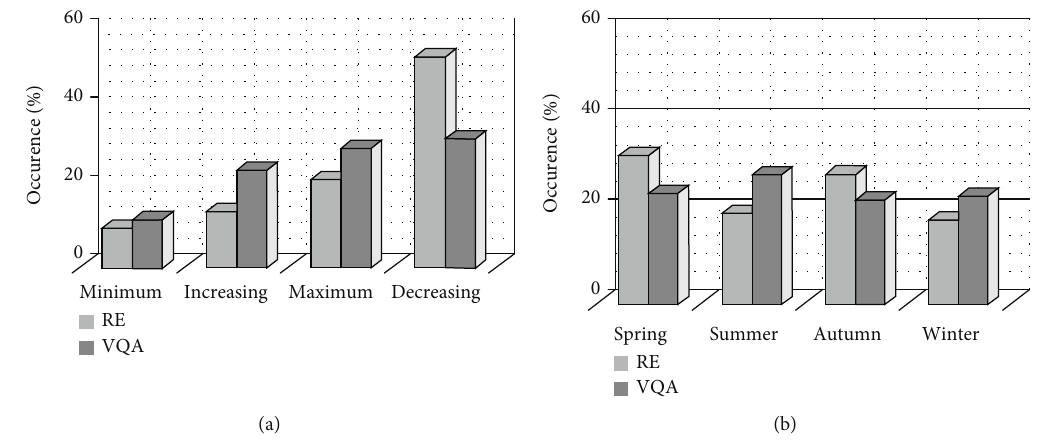
Figure 2: Recurrent events occurrence variability per solar phase (a) and per season